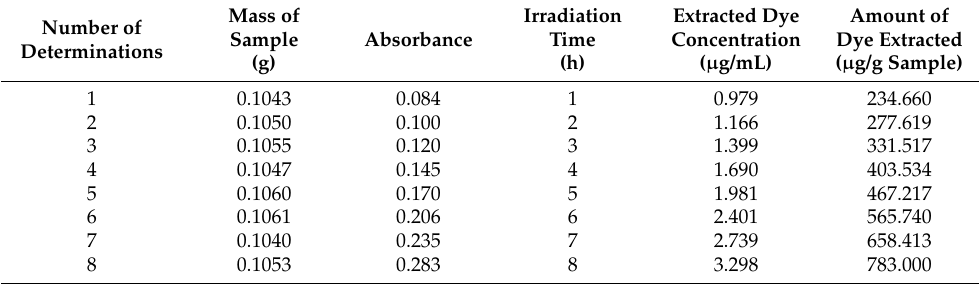
Table 7. Absorbance dependence of irradiation duration and 5% concentration of dye extracted from fiber in an alkaline